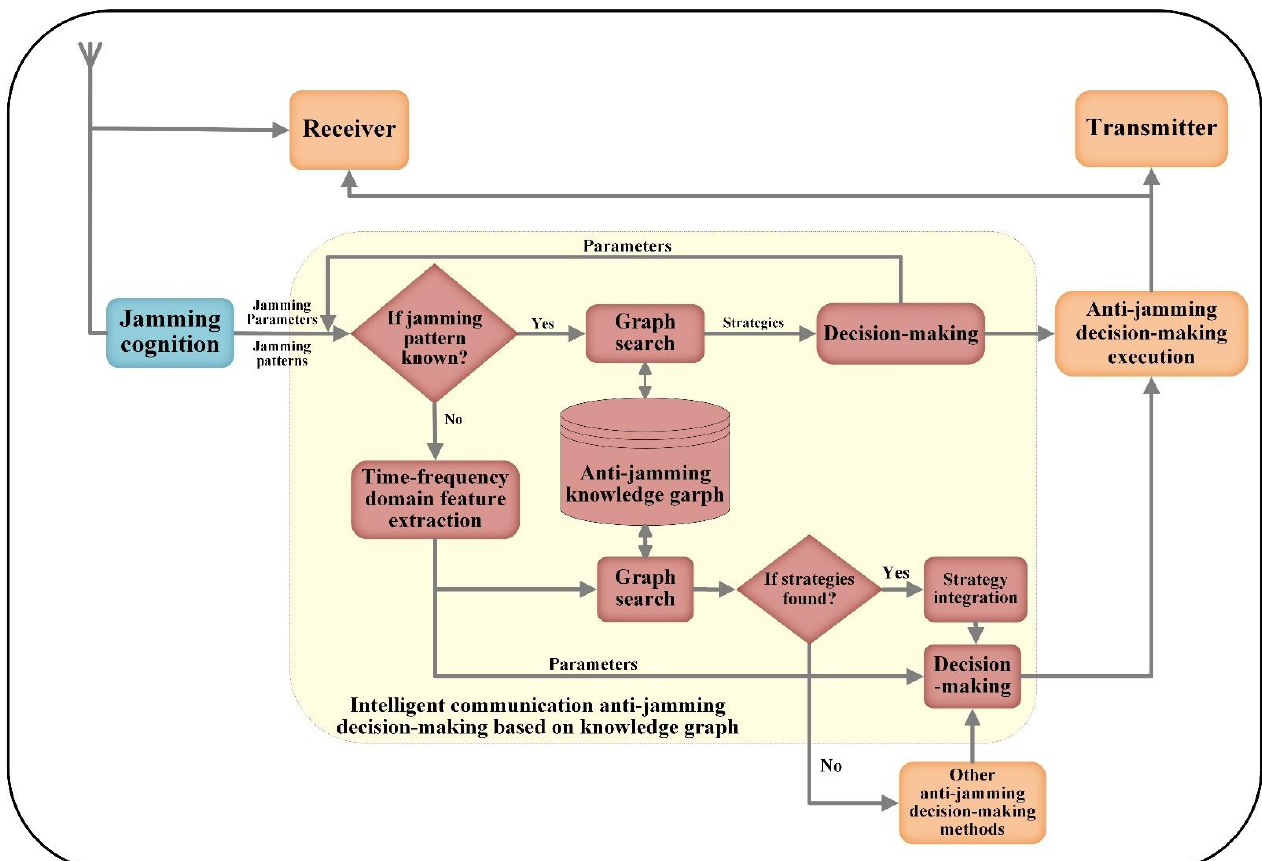
Figure 2. The detailed block diagram of the anti-jamming decision-making module in Figure 1.